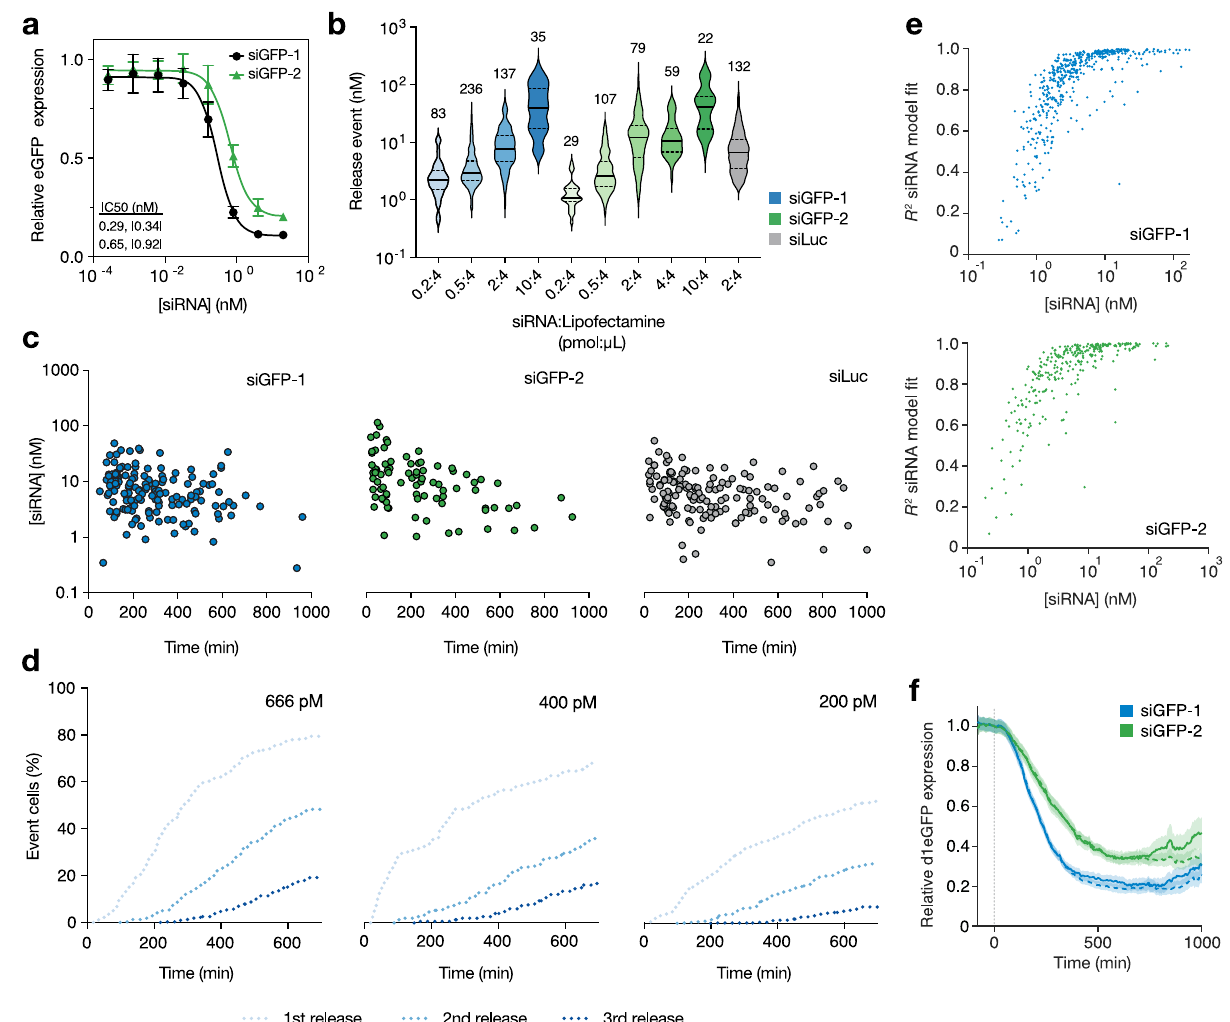
Fig. 4 | Magnitude of cytosolic delivery is determined by the siRNA-to-lipid ratio. HeLa cells stably expressing d1-eGFP were treated with lipoplexed AF647- siRNA targeting eGFP (siGFP-1 or siGFP-2) and analyzed by a fl ow cytometry